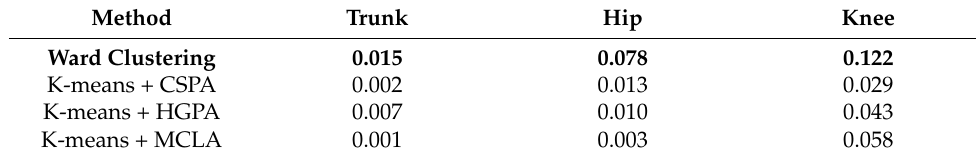
Table 4. Partial eta squared effect size result between different methods.